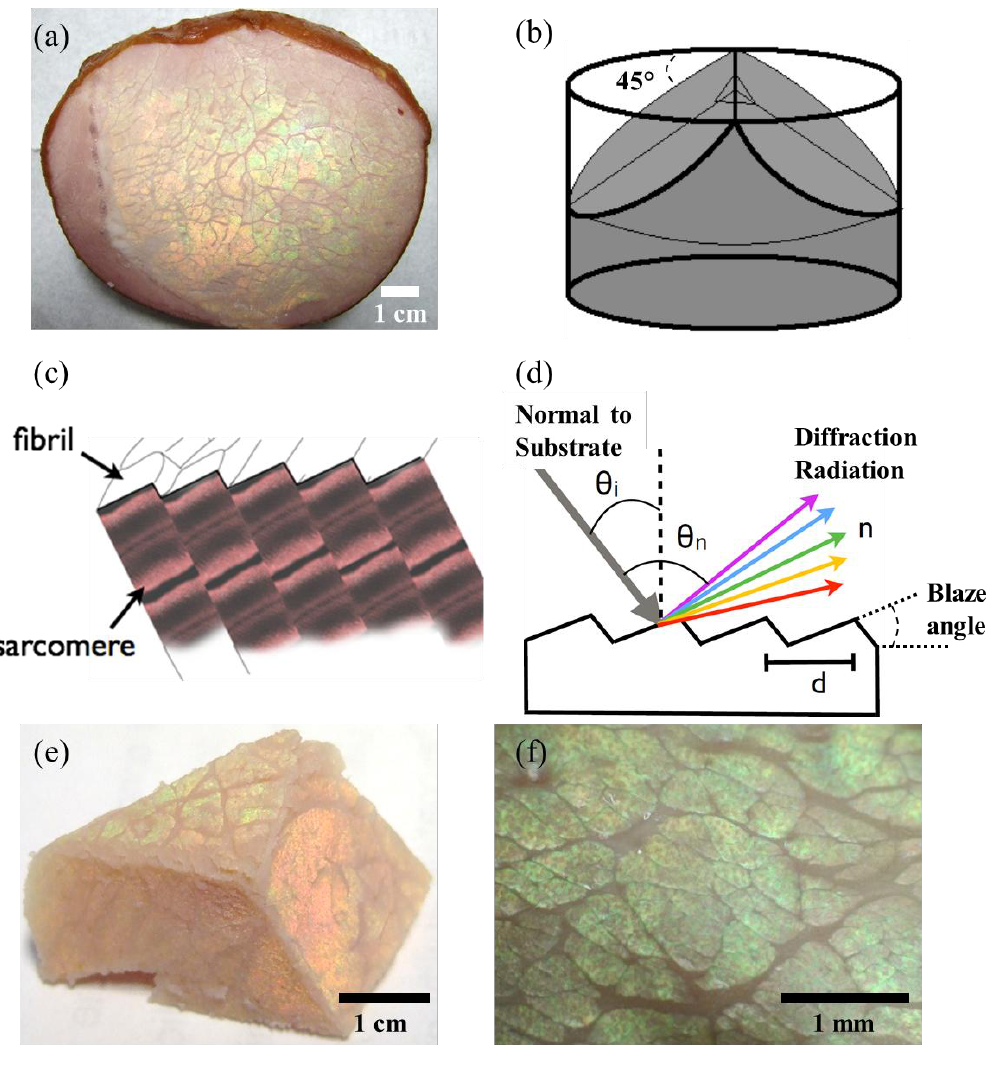
Figure 1. Muscle tissue of a pork loin sample displays iridescence when viewed at a specific angle. ( a ) The loin muscles sliced transversely to the long axes of muscle fibres. ( b ) Section planes of muscle tissue prepared for observing fibres from different angles. ( c ) A schematic of the periodicity of muscle fibres and fibrils. ( d ) The light